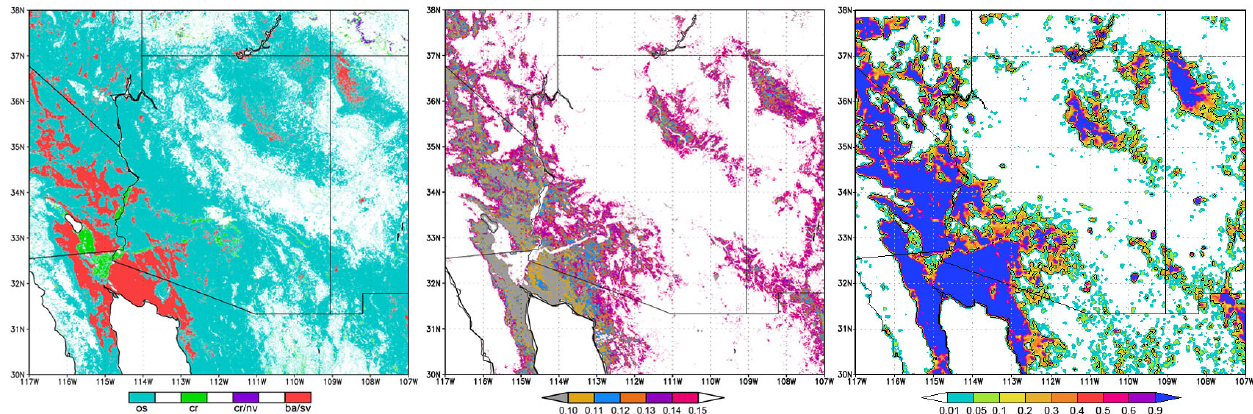
Fig. 1. MODIS land cover types: open shrubland – os, cropland – cr, cropland/native vegetation – cr/nv, barren/sparsely vegetated – ba/sv (left); NDVI (middle); mask of potentially dust productive areas on model resolution